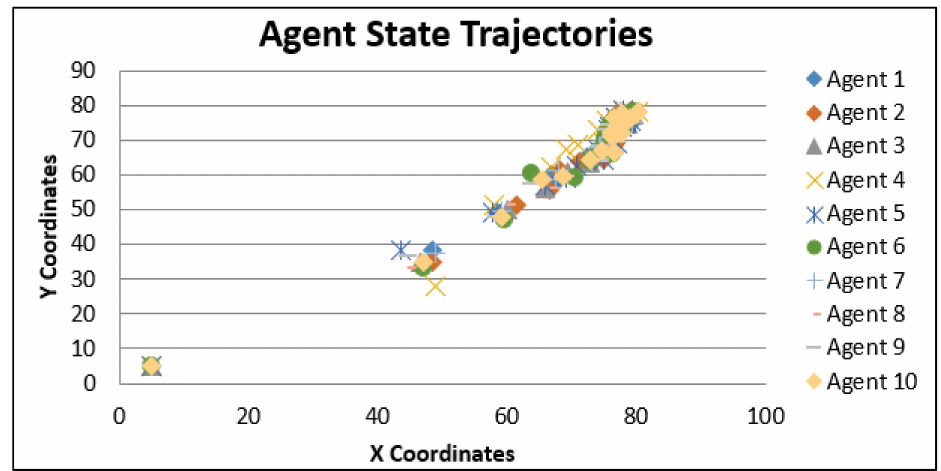
Figure 10. Agent state trajectories (BTT).